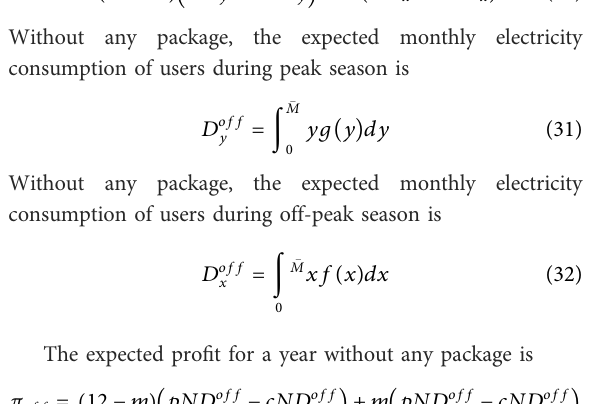
FIGURE 5 Particle swarm optimization convergence process.